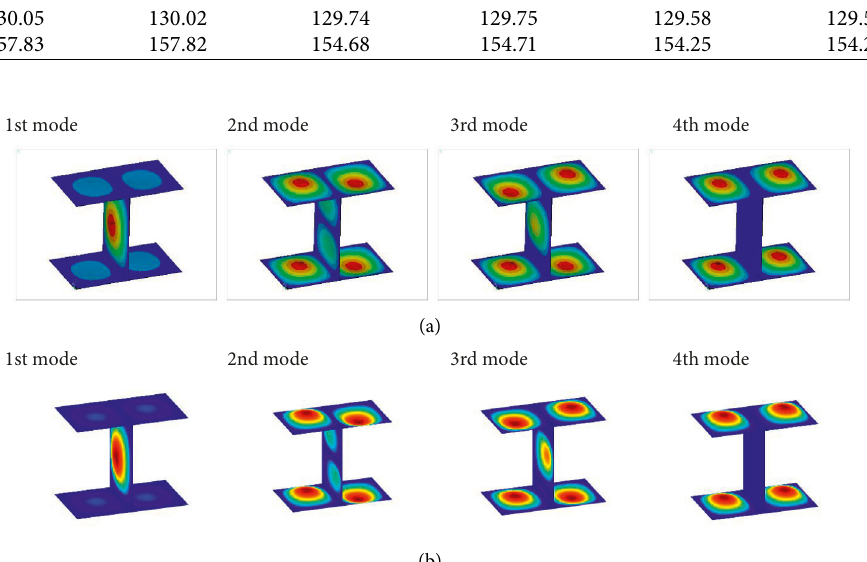
Figure 3: First four vibration mode shapes of the stiffened panel structure in the stiffened double panel-cavity coupled system: (a) results from ANSYS and (b) results from the current method.